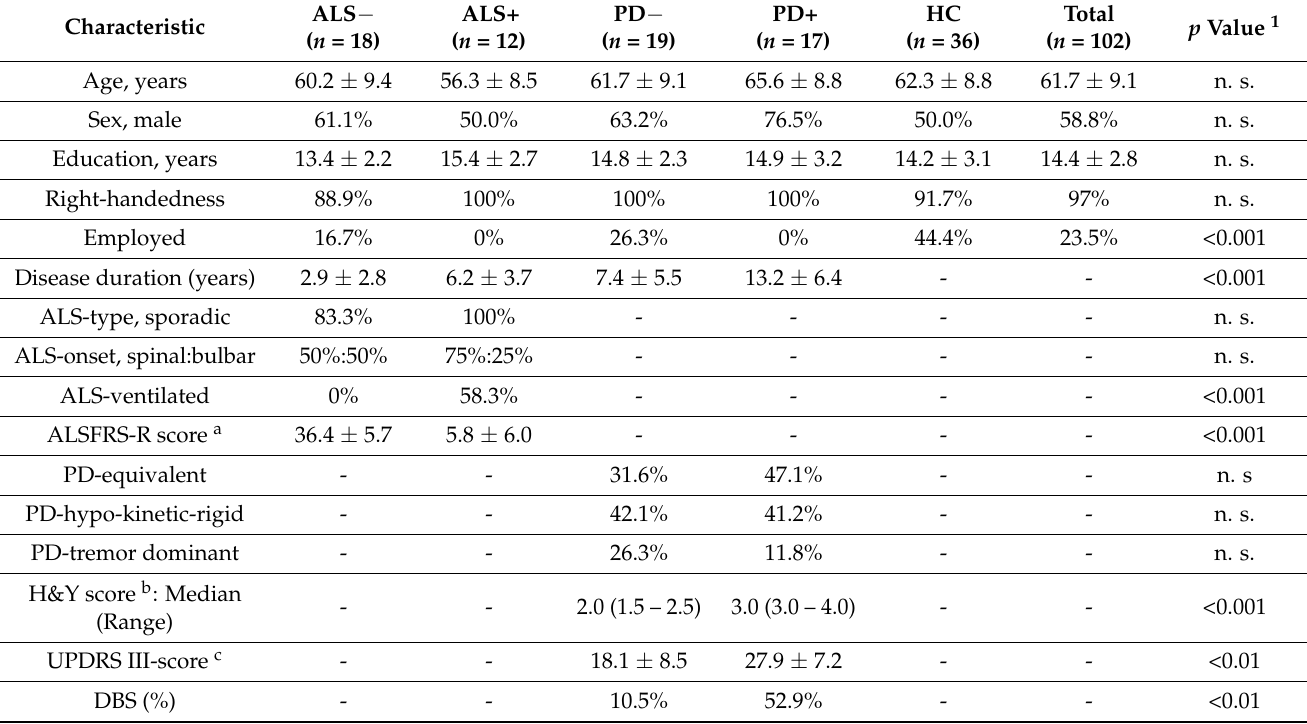
Table 1. Demographic and clinical characteristics and psychosocial